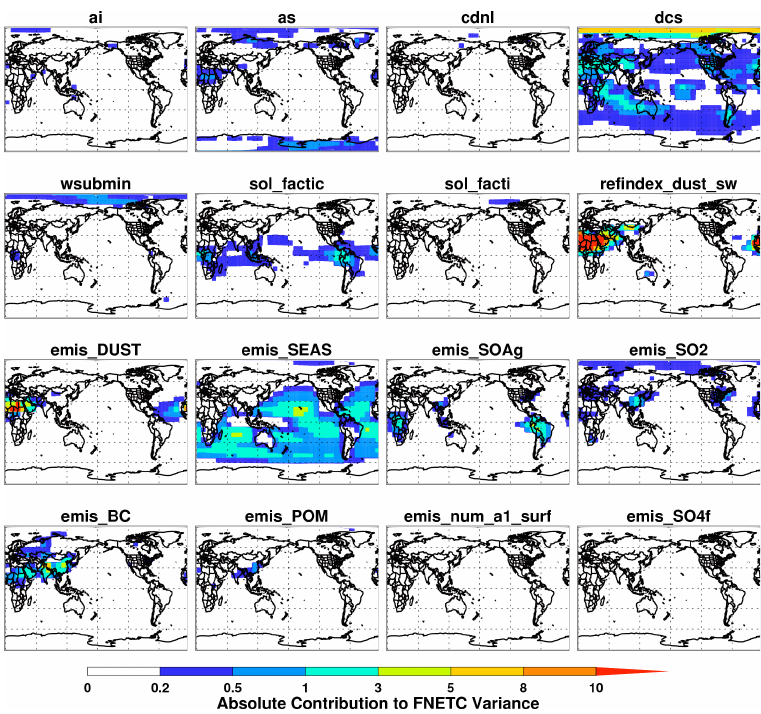
Figure 10 Global spatial distribution of absolute FNETC variance (unit in W 2 /m 4 ) in response to the perturbation of each of the 16 input parameters predicted by the GLM.